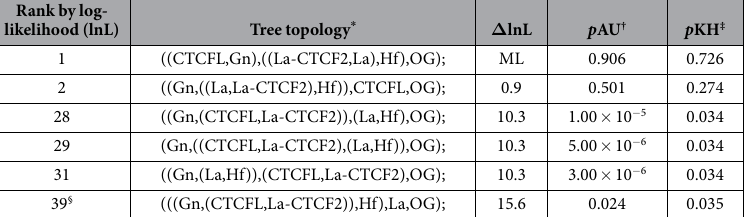
Table 1. Tree topology test for the phylogenetic relationship between CTCFL and CTCF2 . * Gn, gnathostome CTCF; La, lamprey CTCF; Hf, hagfish CTCF; OG, outgroup CTCF. † p -value of the approximately unbiased